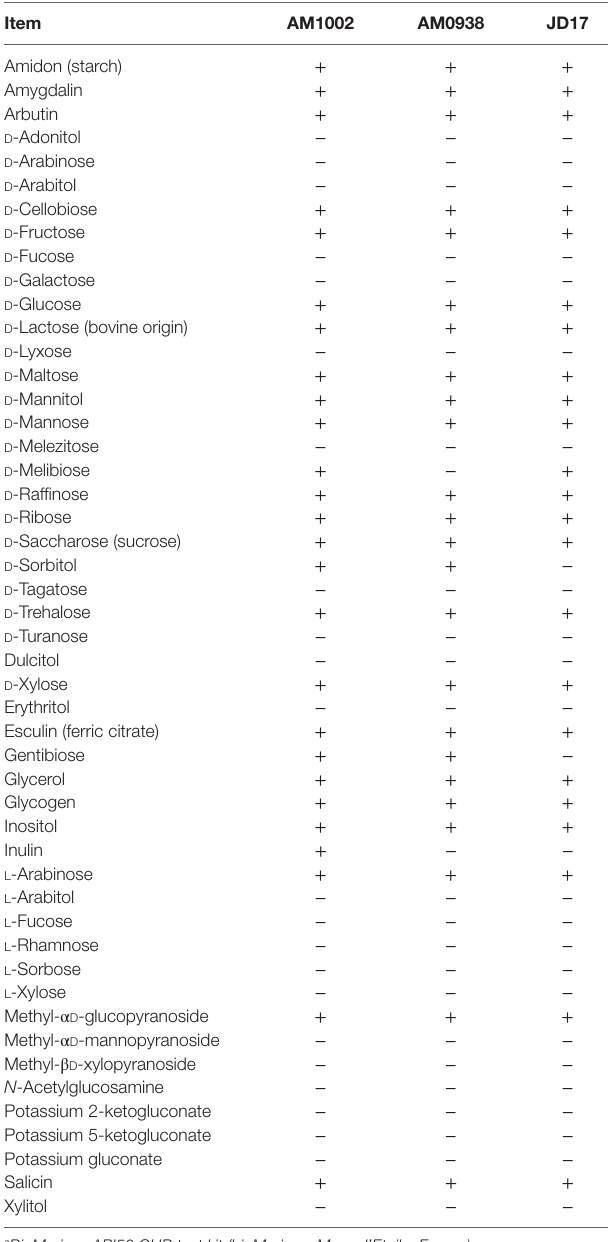
TaBle 3 | characterization and identification of selected Bacillus -DFM candidate strains based on biochemical carbohydrate